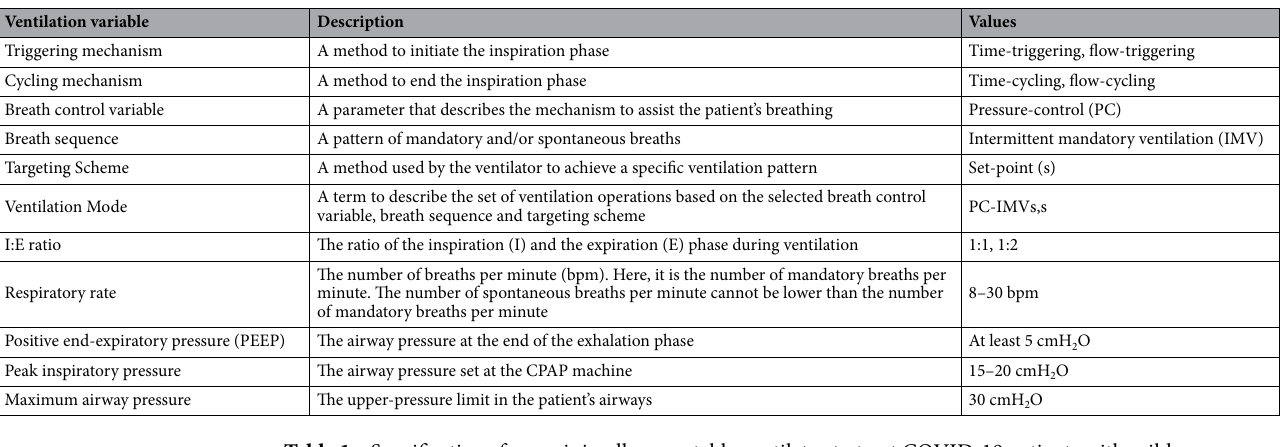
Table 1. Specifications for a minimally acceptable ventilator to treat COVID-19 patients with mild or moderate symptoms.